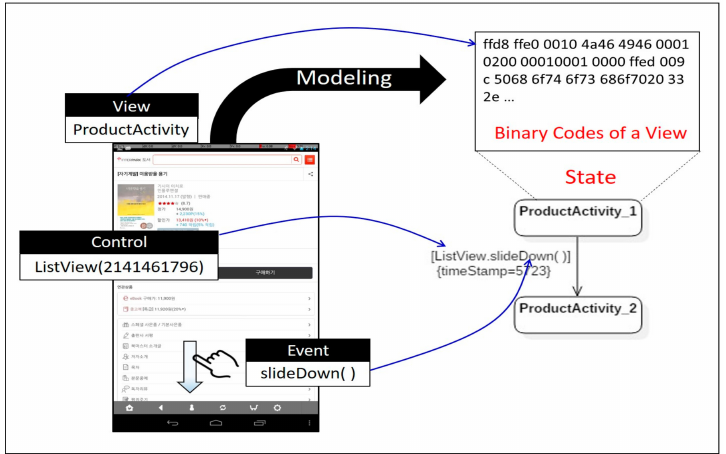
Figure 5. Transition from action log to activity